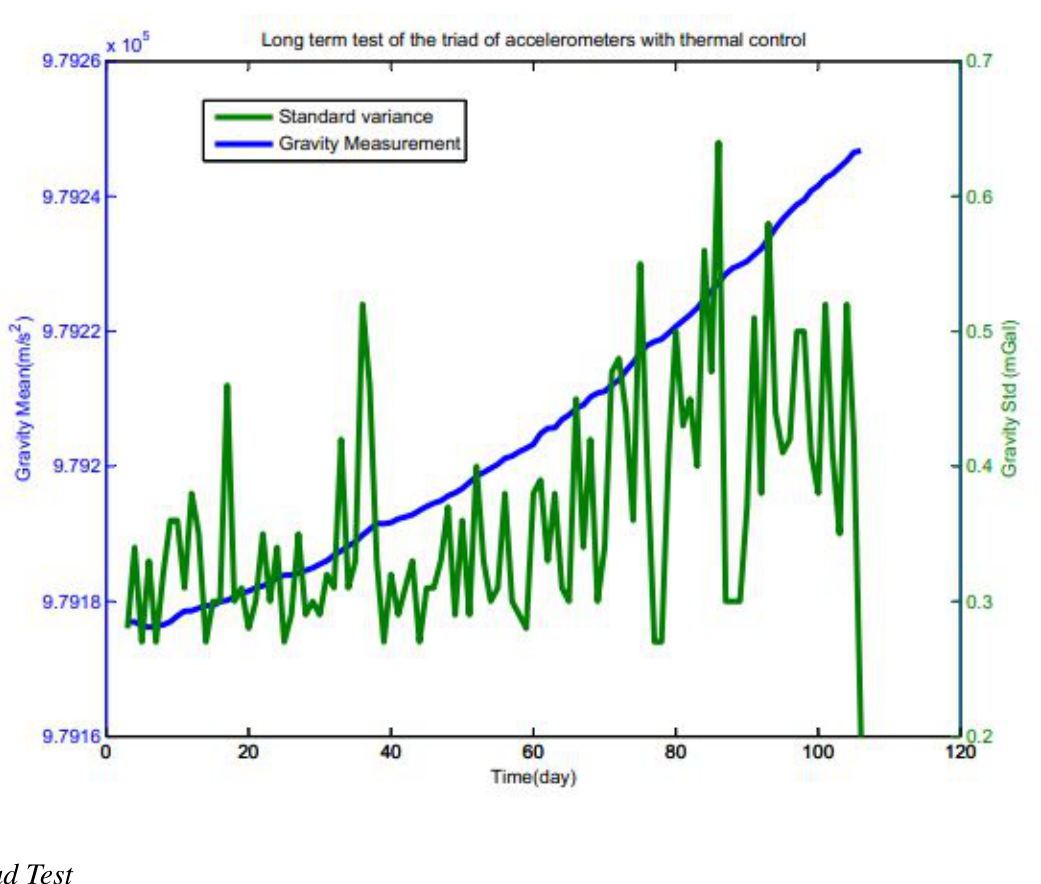
Figure 3. Vertical quantity test results of the triad of accelerometers with thermal control in 104